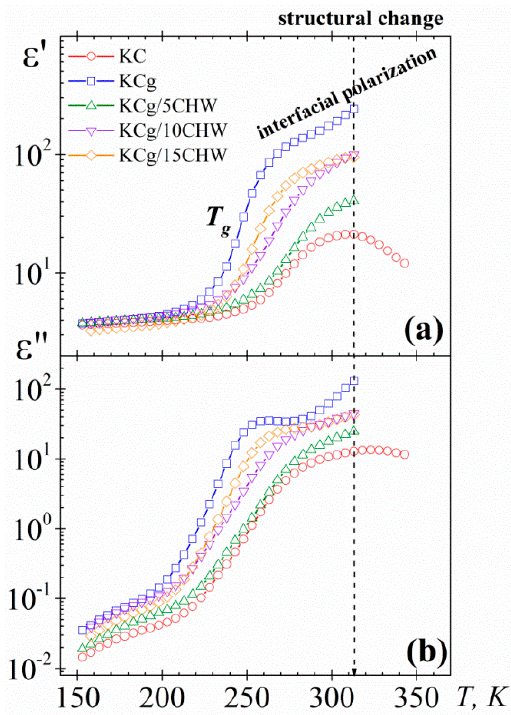
Figure 2. Temperature dependence of ( a ) the dielectric permittivity ( ε ′ ) and ( b ) the dielectric loss ( ε ″ ) at 10 2 Hz for the samples studied.